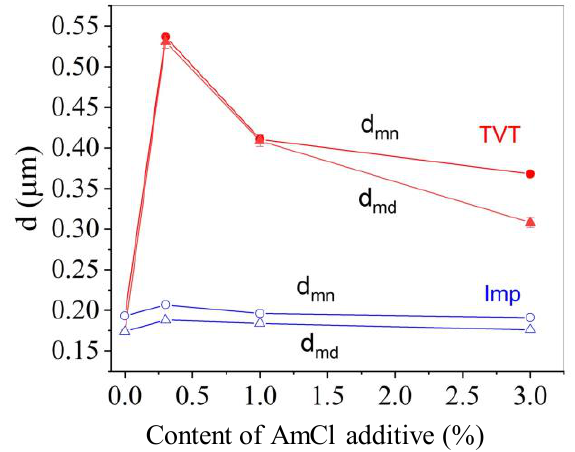
Figure 5. Dependence of the average particle (crystal) size of ZnO powder on the concentration of AmCl and the activation method: impregnation (Imp, blue line) and TVT (red line). Letters indicated: